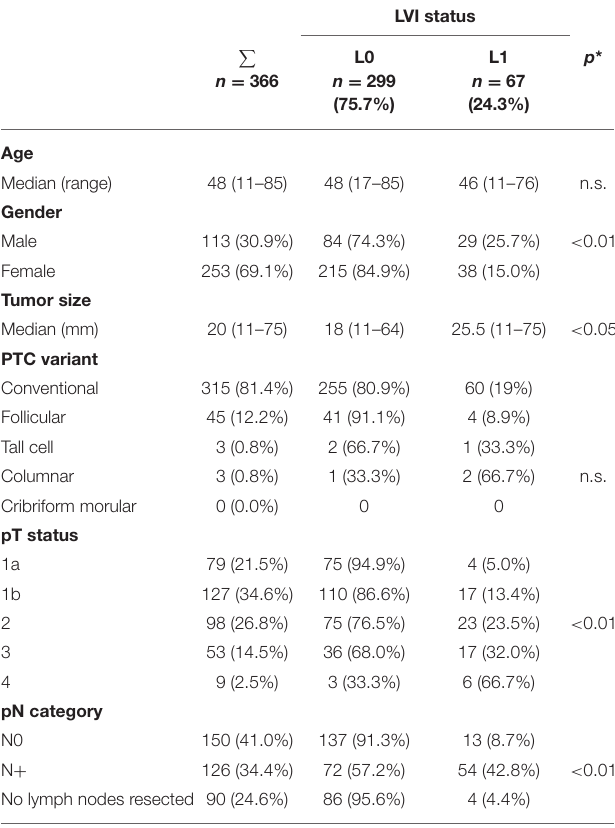
TABLE 2 | LVI presence (L1) and absence (L0) and clinicopathologic variables ( * p -values are calculated for L0 vs.